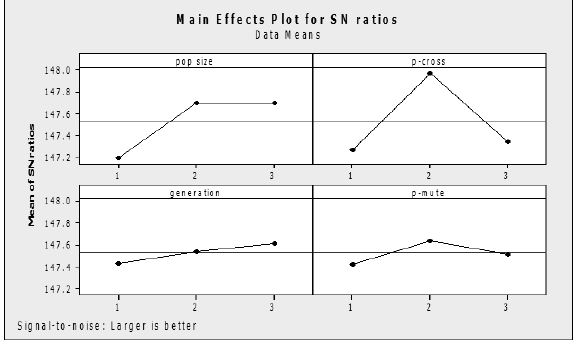
Fig. 3. The results of Taguchi method for parameter setting